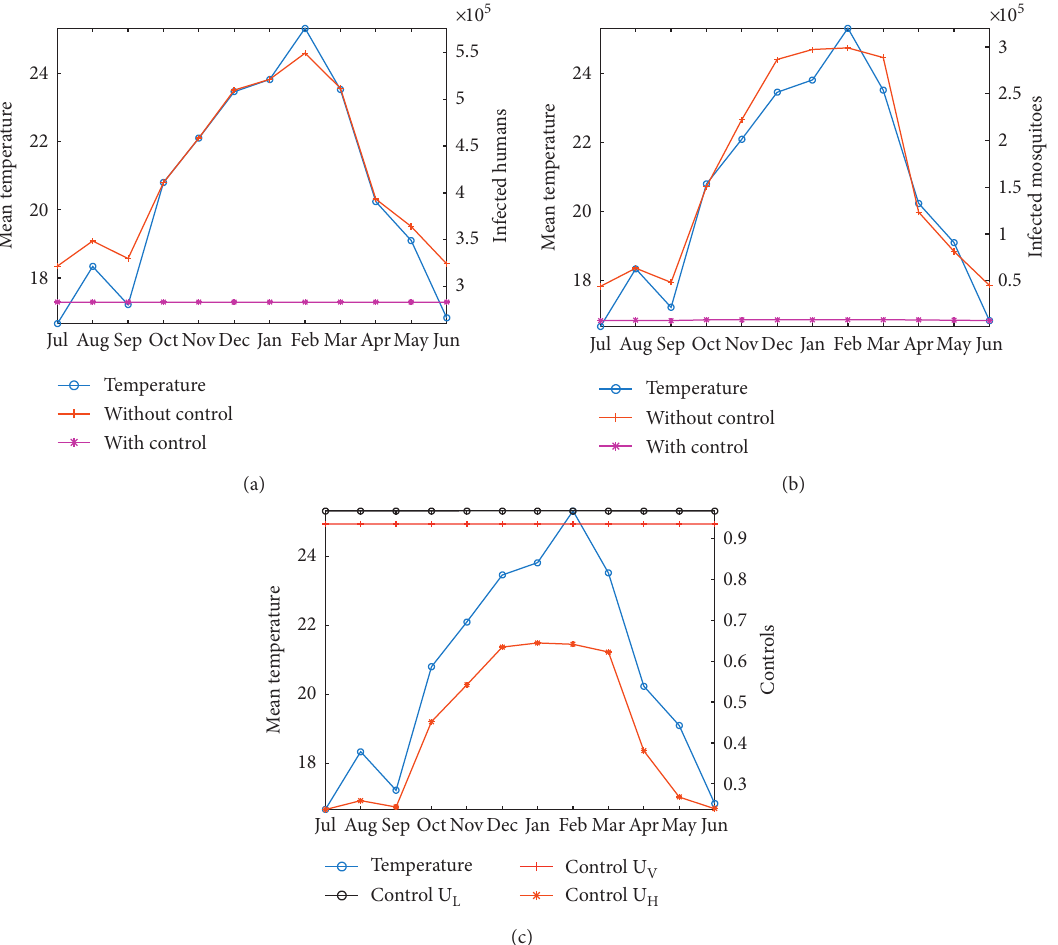
Figure 4: Simulations of the model (2) as a function of time plotting the monthly total number of infected humans and mosquitoes in KwaZulu-Natal, South Africa. (a) Total number of infected humans. (b) Total number of infected mosquitoes. (c) Optimal controls u ( t ) ,u ( t ) , and u ( t ) . The mean monthly temperature is plotted in blue lines and is superimposed onto each figure. H L V